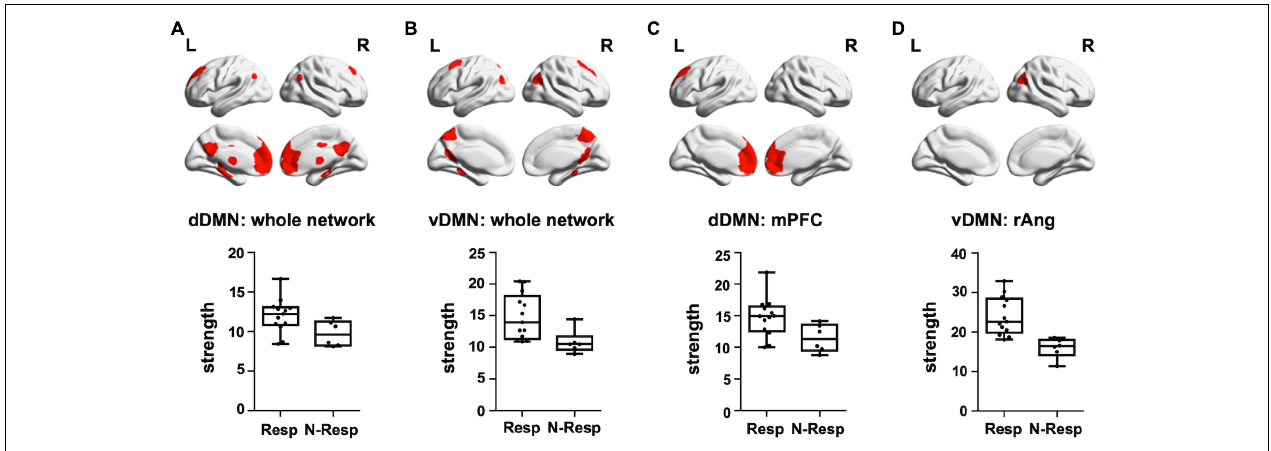
FIGURE 4 | Top—Brain masks covering the (A) dDMN, (B) vDMN, (C) medPref ROI within the dDMN, and (D) rAng ROI within the vDMN, are shown in red on a standard template. Bottom—Graphical representation of strength values for each group (Resp and N-Resp) within the DMN-related areas of interest. dDMN, dorsal default mode network; vDMN, ventral default mode network; medPref, medial prefrontal cortex; rAng, right angular gyrus; Resp, Responders; Non-resp, Non-responders; L, left; R,